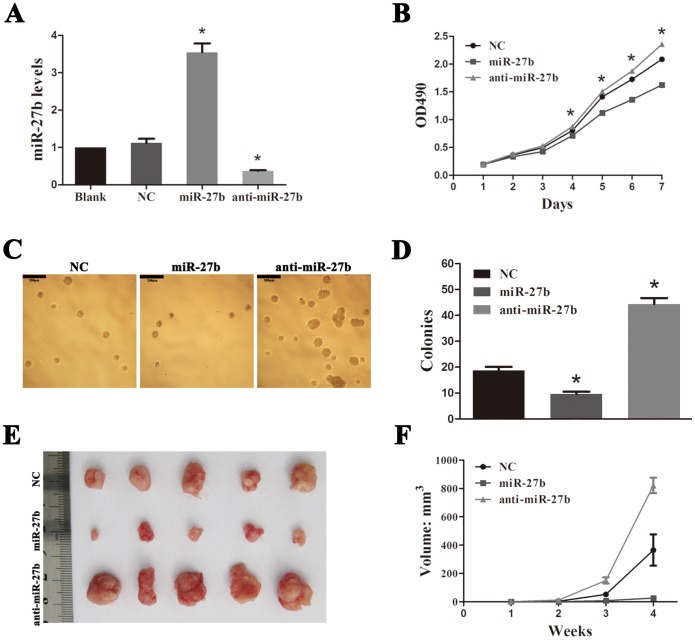
miR-27b inhibits tumor growth in colorectal cancer (CRC).(A) miR-27b expression in negative control (NC), miR-27b and anti-miR-27b SW620 cell lines were assessed by qPCR. The y-axis indicates fold change. (B) Cell proliferation rate detected by measuring the absorbance at 490 nm in an MTS assay. (C and D) Results of a soft-agar colony assay. Colonies were visualized by microscopy after 2 weeks of incubation. Colonies containing >20 cells were counted. Scale bars = 200 µm. (E) Results from a tumorigenesis assay. A representative image of xenograft tumors in nude mice injected subcutaneously with 1×106 CRC cells. (F) Comparison of xenograft formation in vivo. Tumor volumes were measured each week. Error bars represent the means ± SEM, *P<0.05.